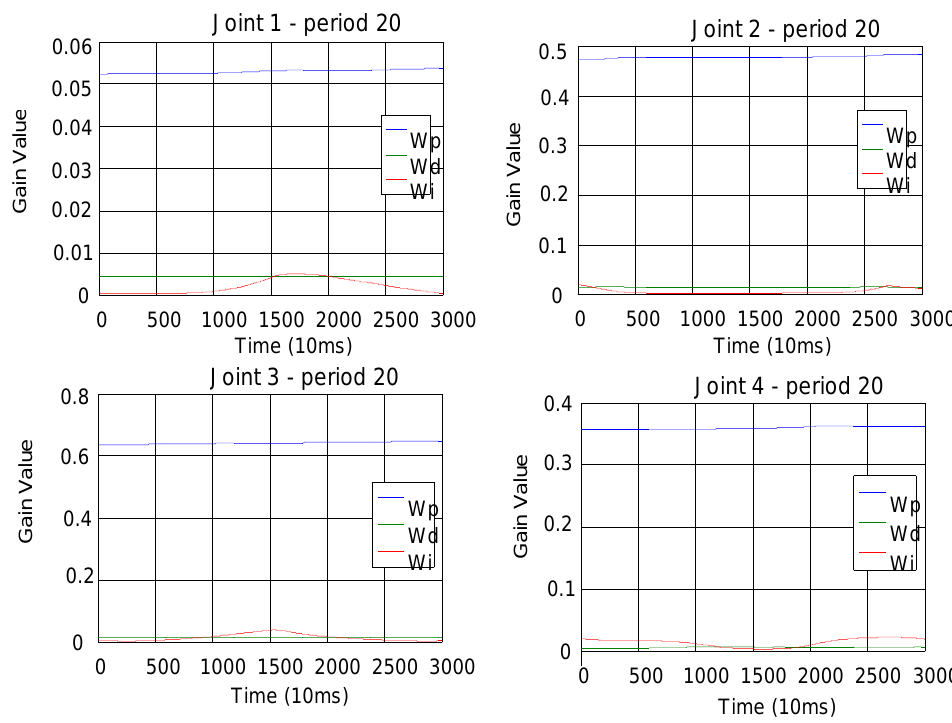
Figure 20. Trajectory 1—four axes—LMS-PID—curve charts of the controller parameters returned by tracking the 20th cycle.